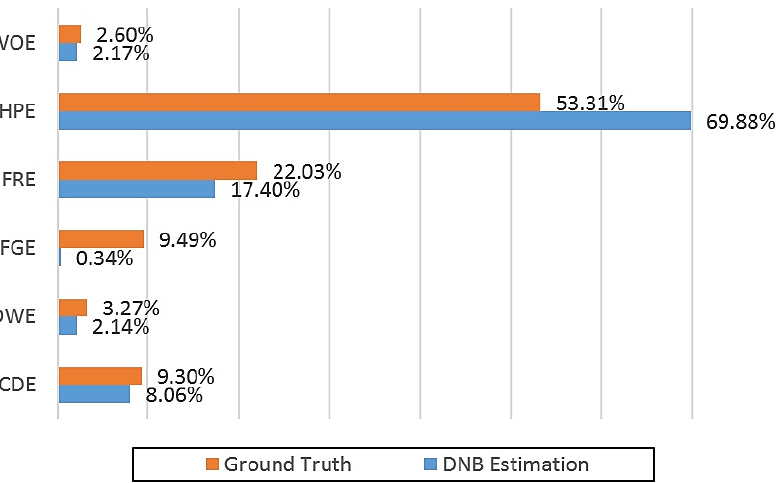
Figure 12. Bar graph showing the breakup of energy consumption per appliance for the ground truth versus estimated results by